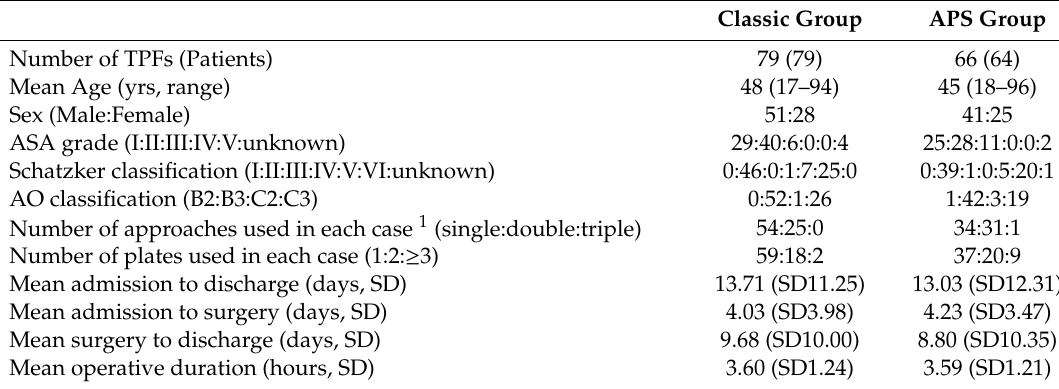
Table 1. Patient demographic, fracture classification and fixation details for both groups.